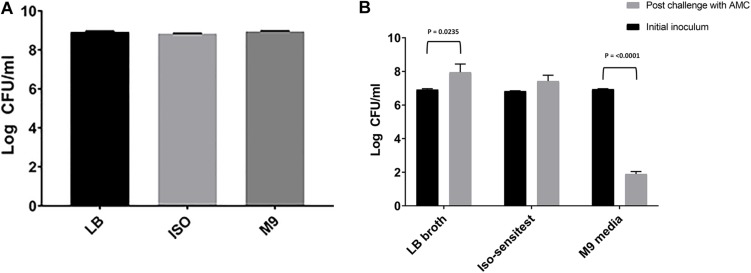
Difference in log CFU/ml of E. coli 10129 (A) after growth in LB, ISO, and M9, and (B) following 24-h exposure with sub-inhibitory concentrations of AMC in LB, ISO, and M9 compared to the initial inoculum. Error bars represent standard error of the mean.